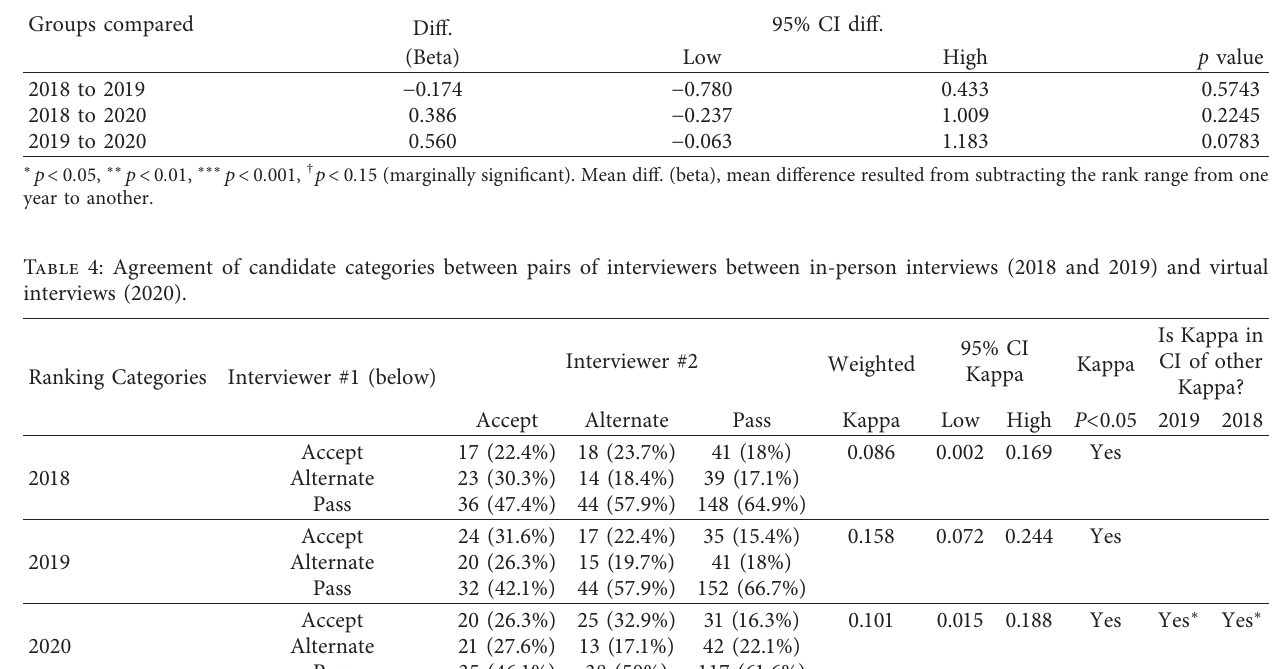
Table 3: Comparison of ranking variabilities of in-person interviews (2018 and 2019) with virtual interviews (2020). Groups compared